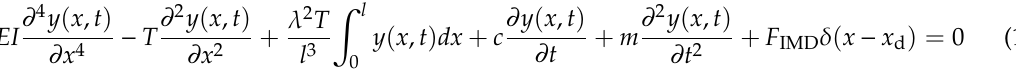
ends ( b ) fixed-fixed ends. 102